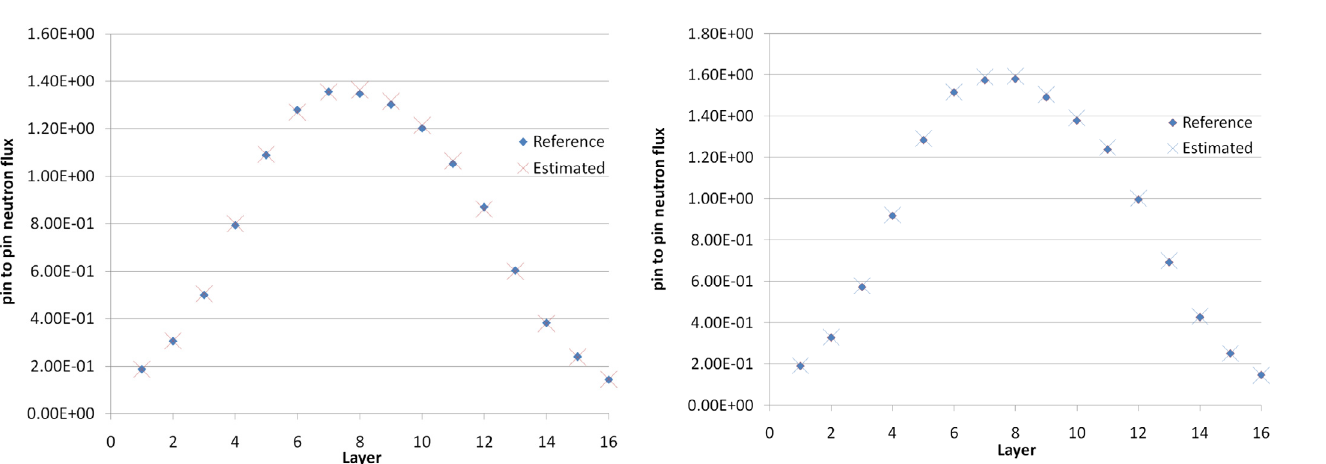
Fig. 4. Comparison of the pin to pin reference fl uxes and those estimated by the algorithm for pin 01 of assembly 01.